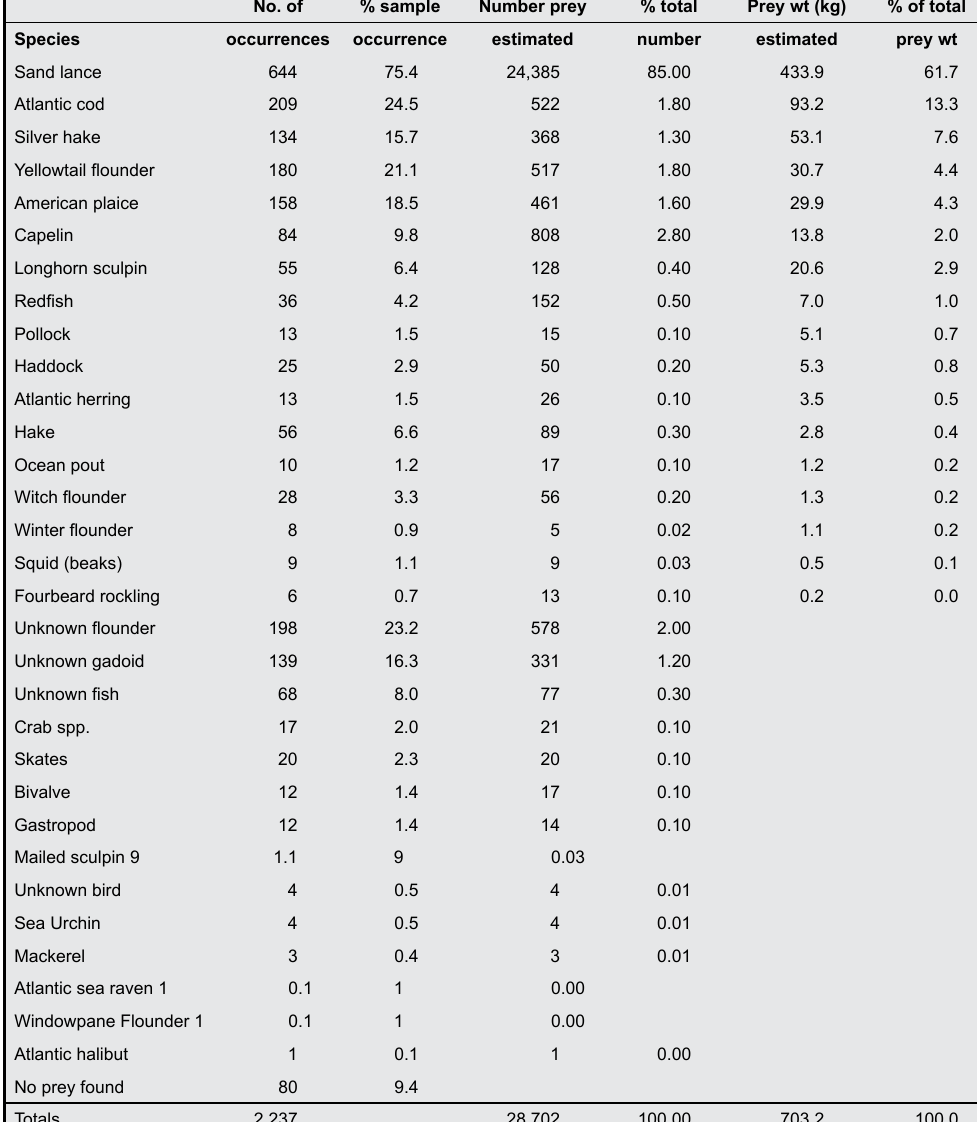
Table 2 . Combined diet 1 of grey seals between May, 1993 and January, 1998. (Scientific names in